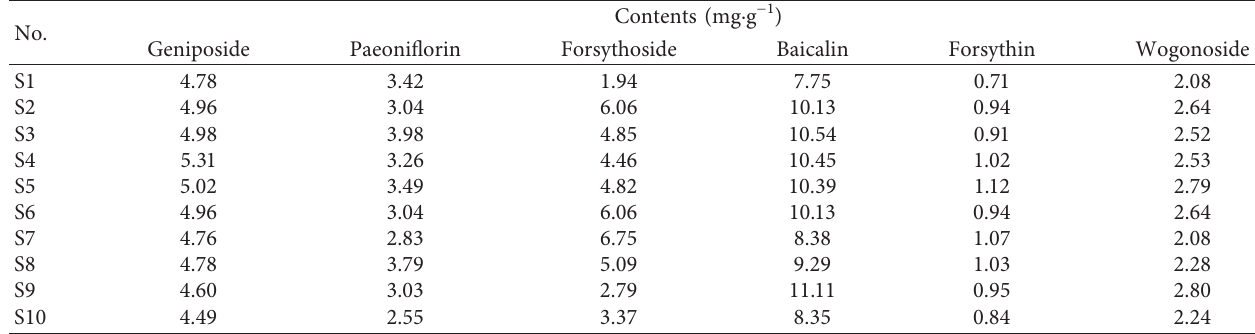
Table 3: The contents of six markers in 16 batches of samples ( n �